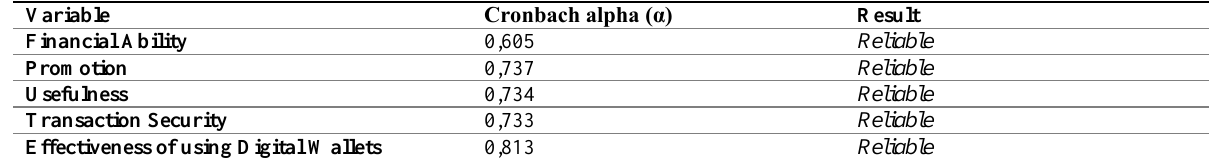
Table 7: Reliability Test Results